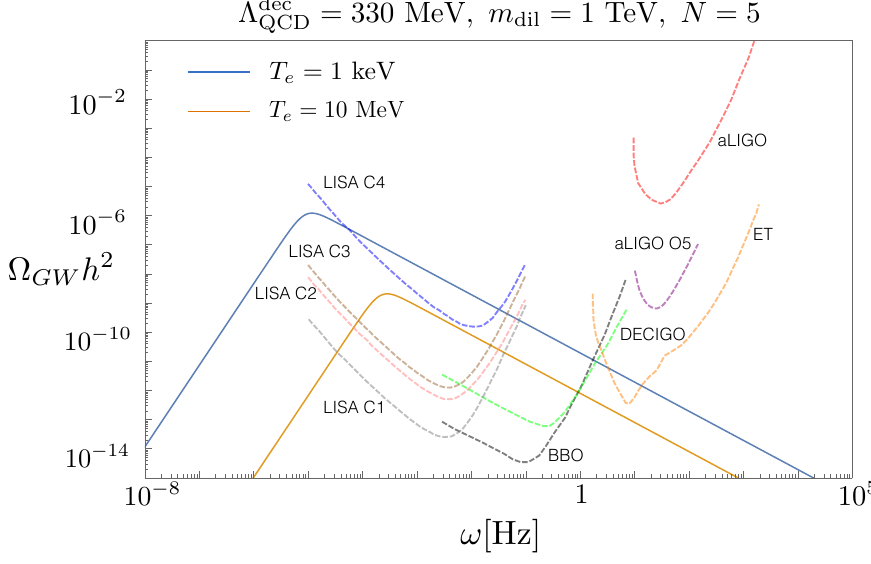
Figure 7 . Relic abundance of gravitational waves from the collision of cosmic bubbles in the supercooling scenario (thick lines, as in the legend), according to eq. (4.18). The sensitivity curves of several future ground- and space-based interferometers are also shown (see [53] for the sensitivity of di(cid:11)erent con(cid:12)gurations of